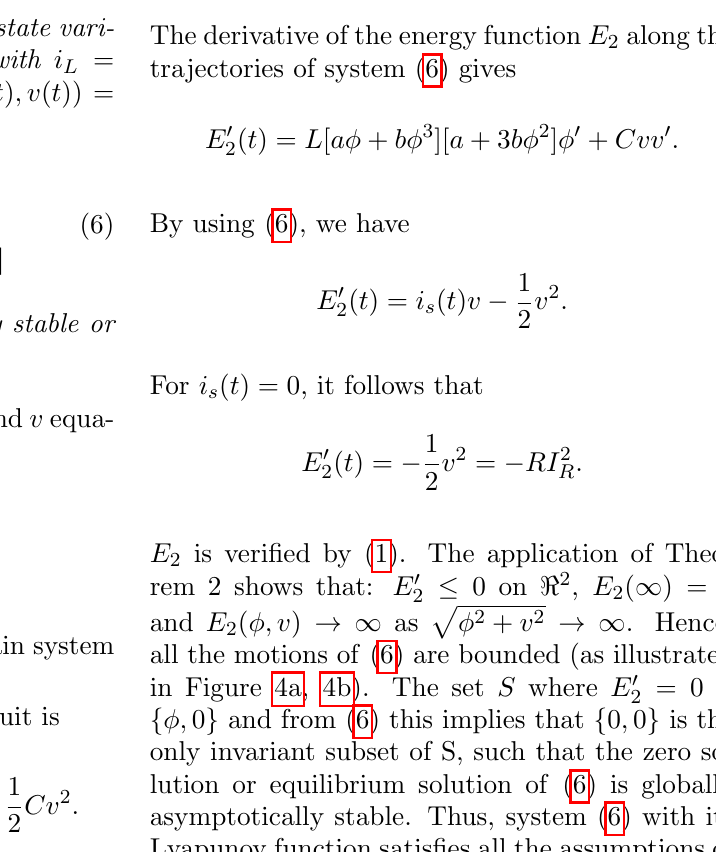
Figure 3. LRC circuit with nonlin- ear inductive